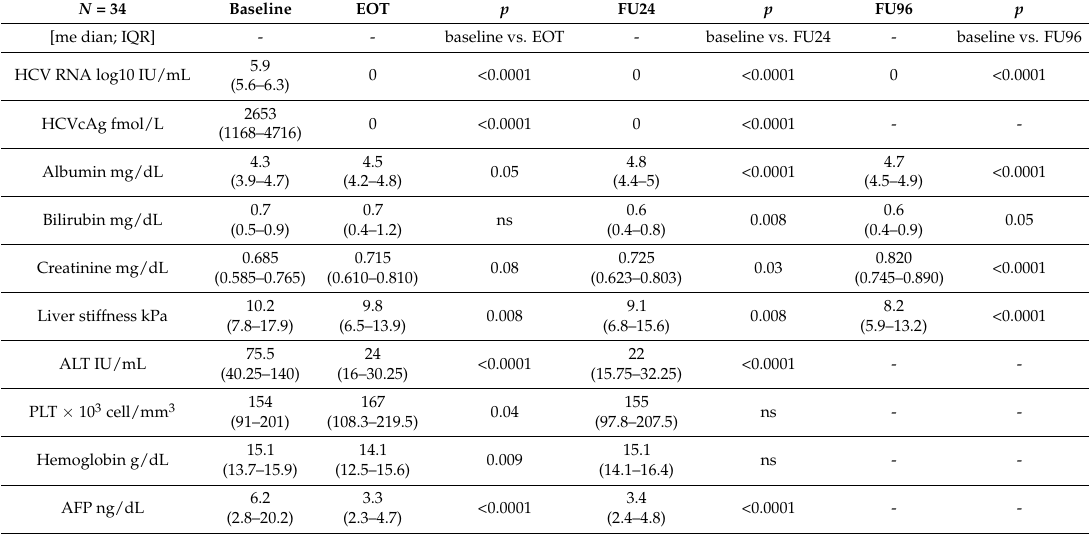
Table 2. Dynamics of changes in laboratory test and liver stiffness during the treatment and follow-up period; p was calculated with Wilcoxon signed rank.